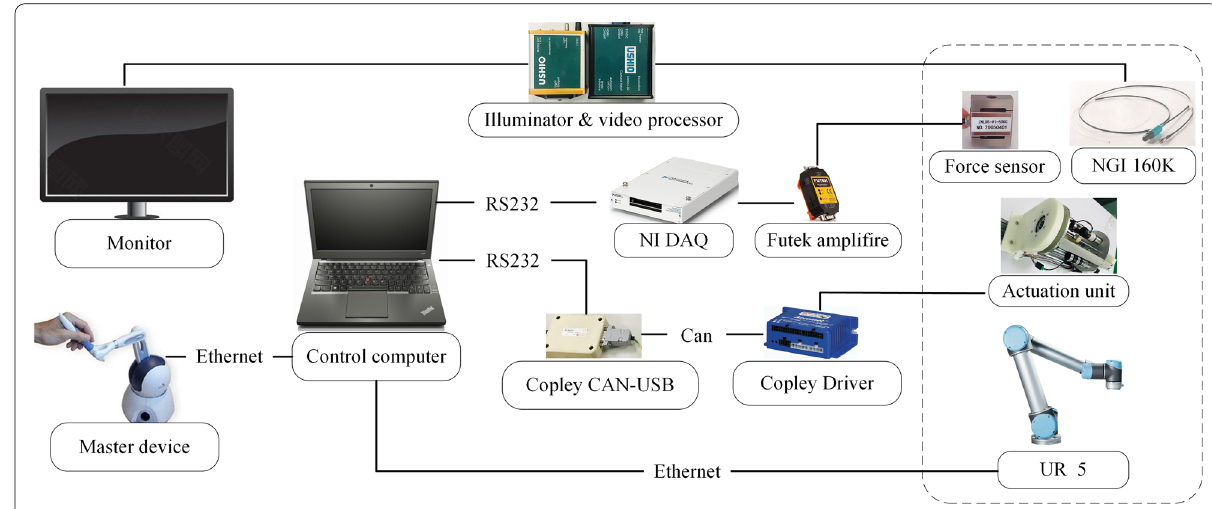
Figure 6 System architecture of robotic system